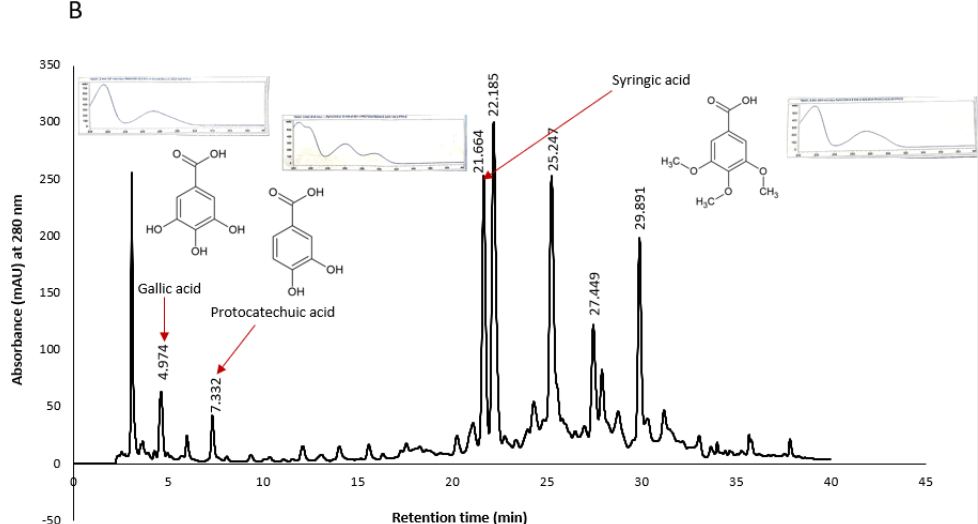
Figure 8. Chromatograms of KPS ( A ) and KPF ( B ) extracts showing tentatively identified peaks based on retention times of standard phenolic compounds.